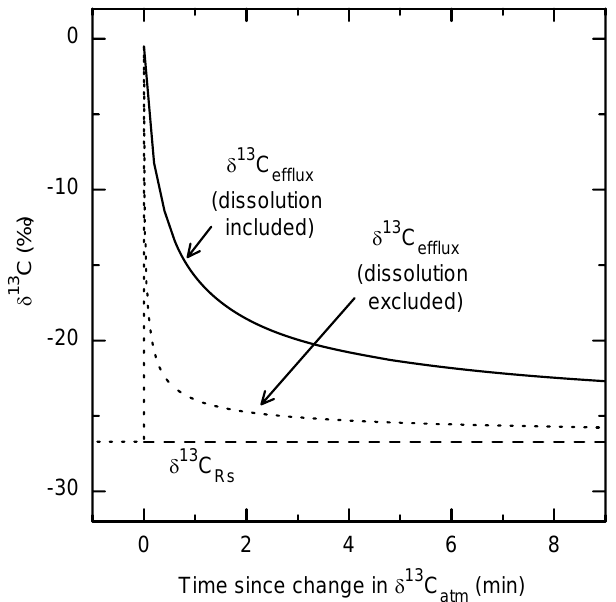
Fig. 5. Modelled δ 13 C efflux following a step change (at time 0) in δ 13 C atm from ambient ( − 8 . 5‰) to labelling conditions ( − 46 . 9‰) when dissolution of CO 2 in soil water was included (solid line, see also Fig. 4c) or excluded in the CO 2 transport model (dotted line). δ 13 C Rs was kept constant at − 26 . 7‰ (dashed line). When lines are overlapping, only the dotted line is